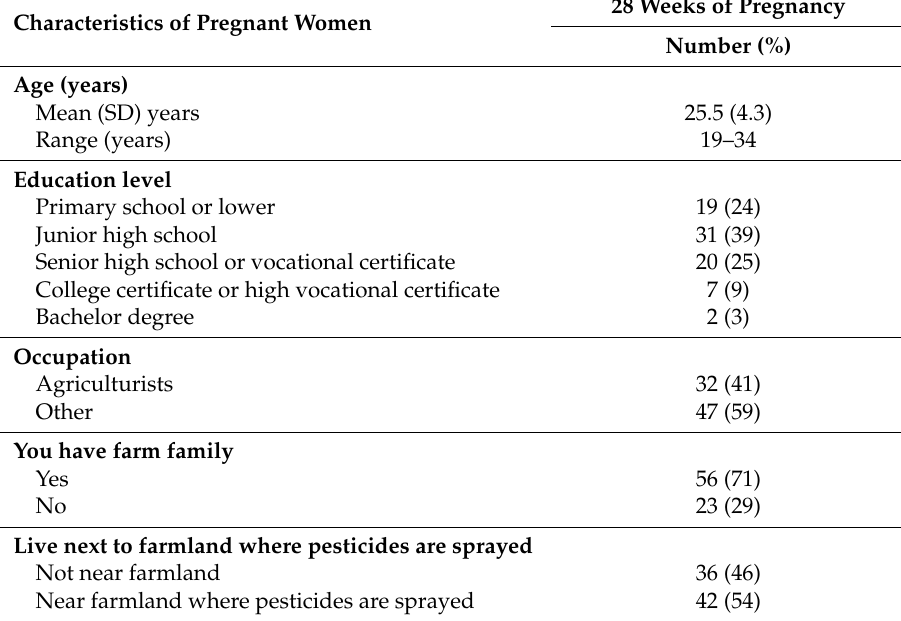
Table 1. Demographic characteristics of pregnant women at 28 weeks of pregnancy ( n =